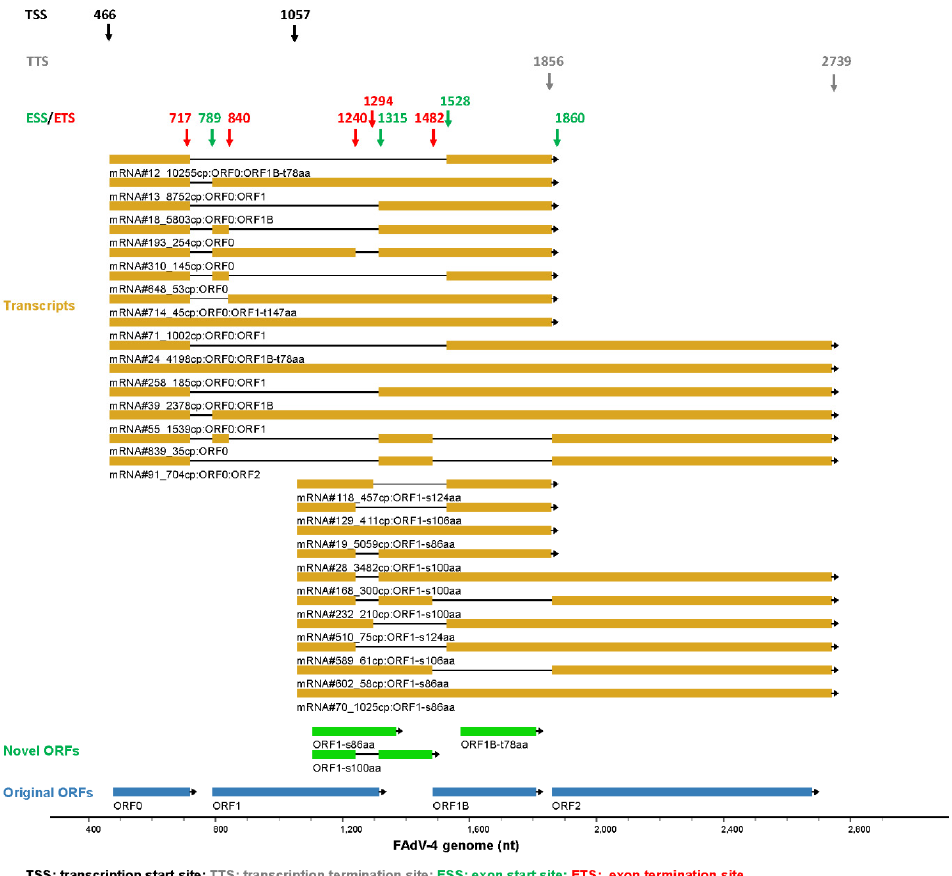
Figure 4. Splicing of mRNAs transcribed from the left end of the forward strand. Transcripts that started at two major TSS (466- or 1057-nt) and terminated at 2 TTS (1856- or 2739-nt) were selected and those with copy numbers greater than 30 were shown. The selective use of splicing donors and receptors generated many spliced transcripts. Since ORF0 could be a small upstream open reading frame (ORF), the ORFs, which started from the second AUG codon at the far-left end of ORF0-containing transcripts, were also labeled. Original ORFs: the ORFs that had been annotated in previous reports. Novel ORFs: the ORFs that were newly found in this